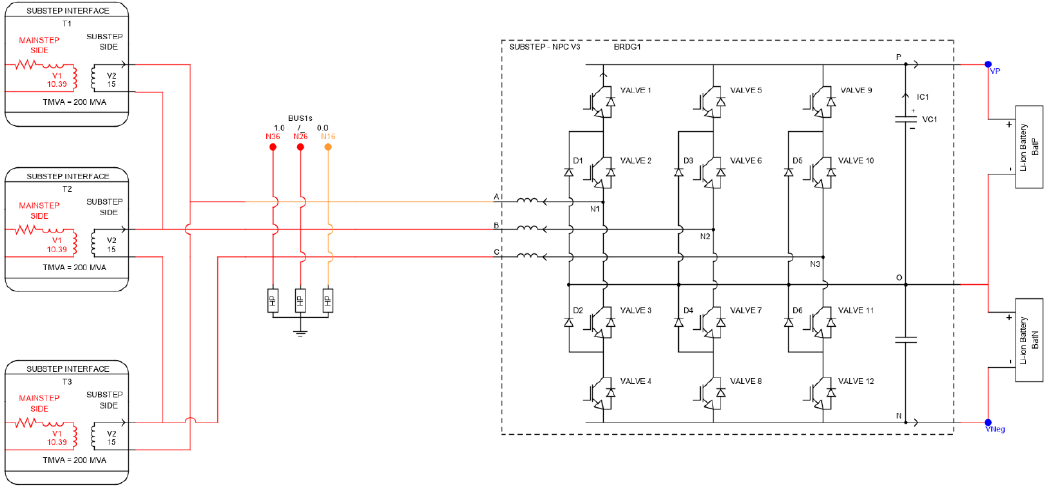
Figure 10. The diagram of BESS with batteries, neutral point clamped (NPC) converter with firing controller, filter and transformer.